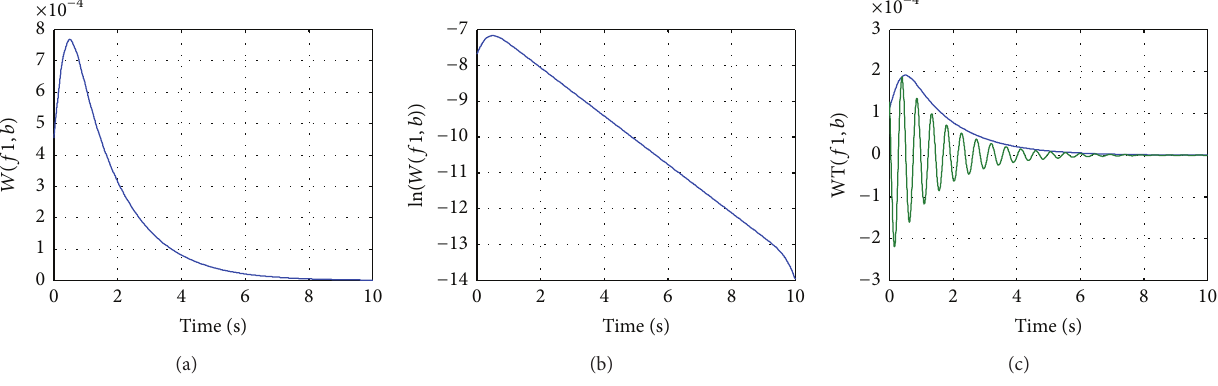
Figure 4: (a) The extracted envelope parallel to frequency axis at the wavelet ridge, (b) semilogarithmic plot of the envelope, and (c) comparison of free decay response and the wavelet